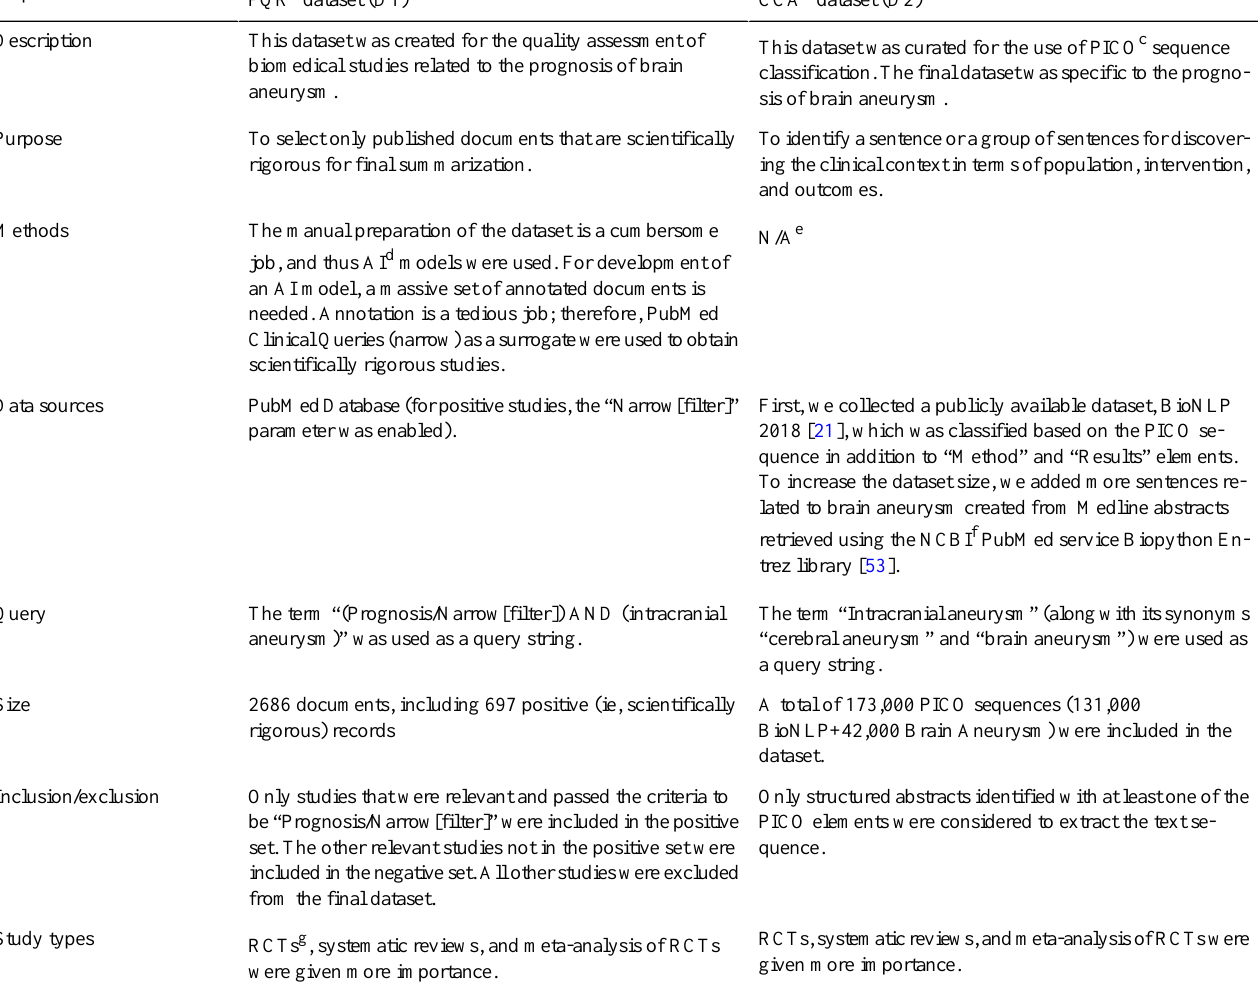
Table 3. Dataset preparation